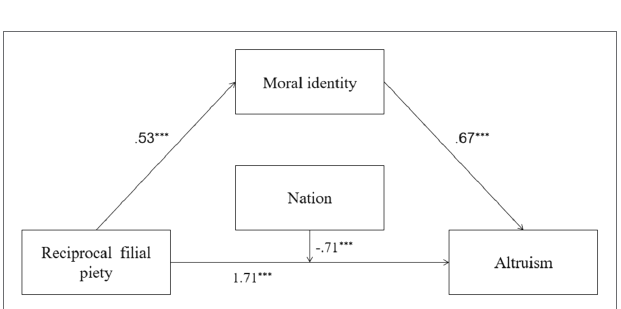
FIGURE 2 | Mediation and moderation model showing standardized coefficients (Model 2); *** p < 0.001.